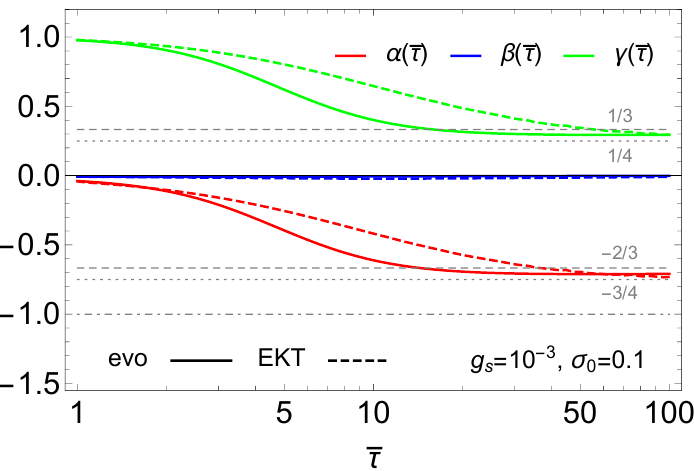
Figure 8 . The comparison between the evolution of the scaling exponents from eq. (6.6) (solid curves) with results from QCD effective kinetic theory (EKT) from ref. [1] (dashed curves). We take the same initial distribution function as the EKT results at τ I . For clarity of presentation, EKT results are the average of exponents computed from different sets of moments of the distribution